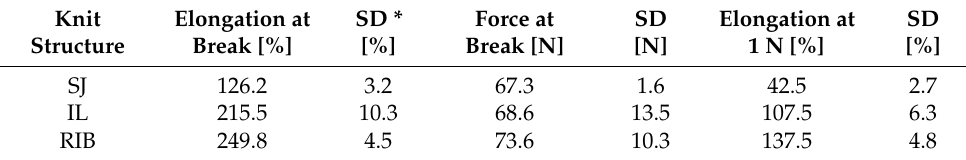
Figure 7. Exemplary tensile test results with resistance values for SJ and IL. Table 5. Results of uni-axial tensile